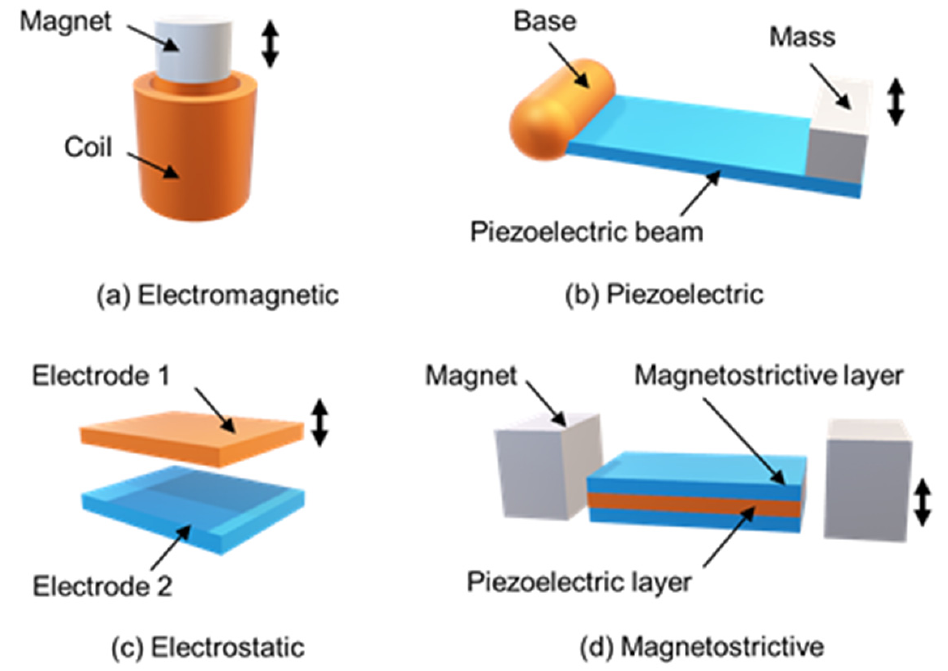
Figure 5. Schematic of the four main principles to convert mechanical to electrical energy. ( a ) Elec- tromagnetic: based on Faraday-Neumann-Lenz, a time-variable magnetic flux and voltage are gen- erated due to the relative motion between a coil and a permanent magnet. ( b ) Piezoelectric: piezoe- lectric materials are used to produce charge under applied stress/strain. ( c ) Electrostatic: a variable capacitor structure used to generate a charge. ( d ) Magnetoelectric: a combination of piezoelectric and magnetostrictive materials.